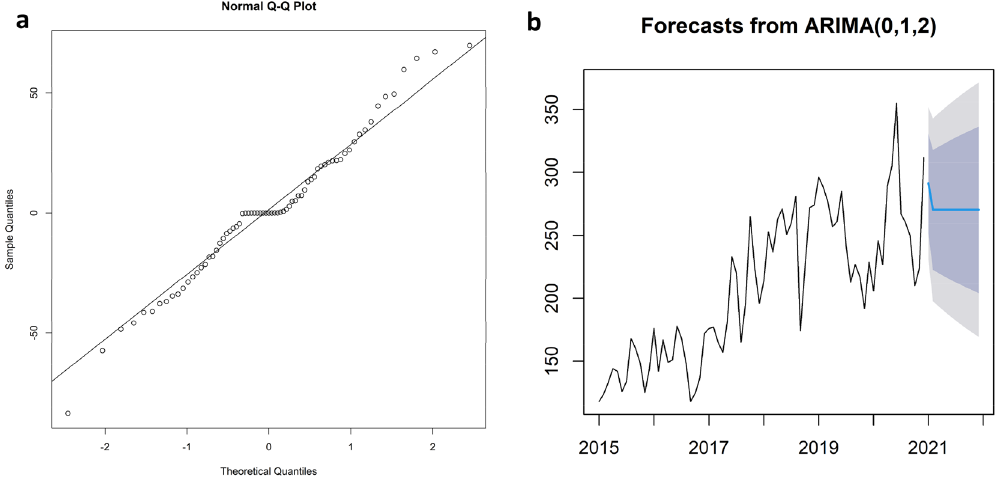
Figure 3. ( a ) Residuals Q.Q. plot, ( b ) Model prediction